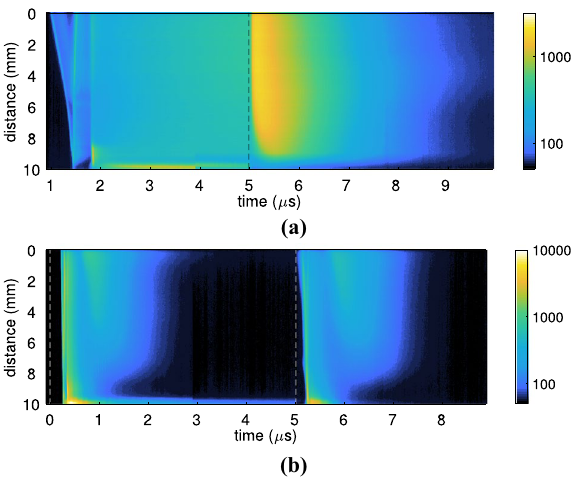
Figure 2. ( a ) The spatio-temporal profile of the light emission from the plasma–liquid interaction when the liquid was electrically grounded through a 1 k (cid:31) resistor. Obtained using fast 10 ns imaging with 480 accumulations each time delay. The end of the capillary was at 0 mm while the liquid was at 10 mm distance. ( b ) The spatio-temporal graph when the resistor was 680 k (cid:31) , with the same acquisition settings as ( a